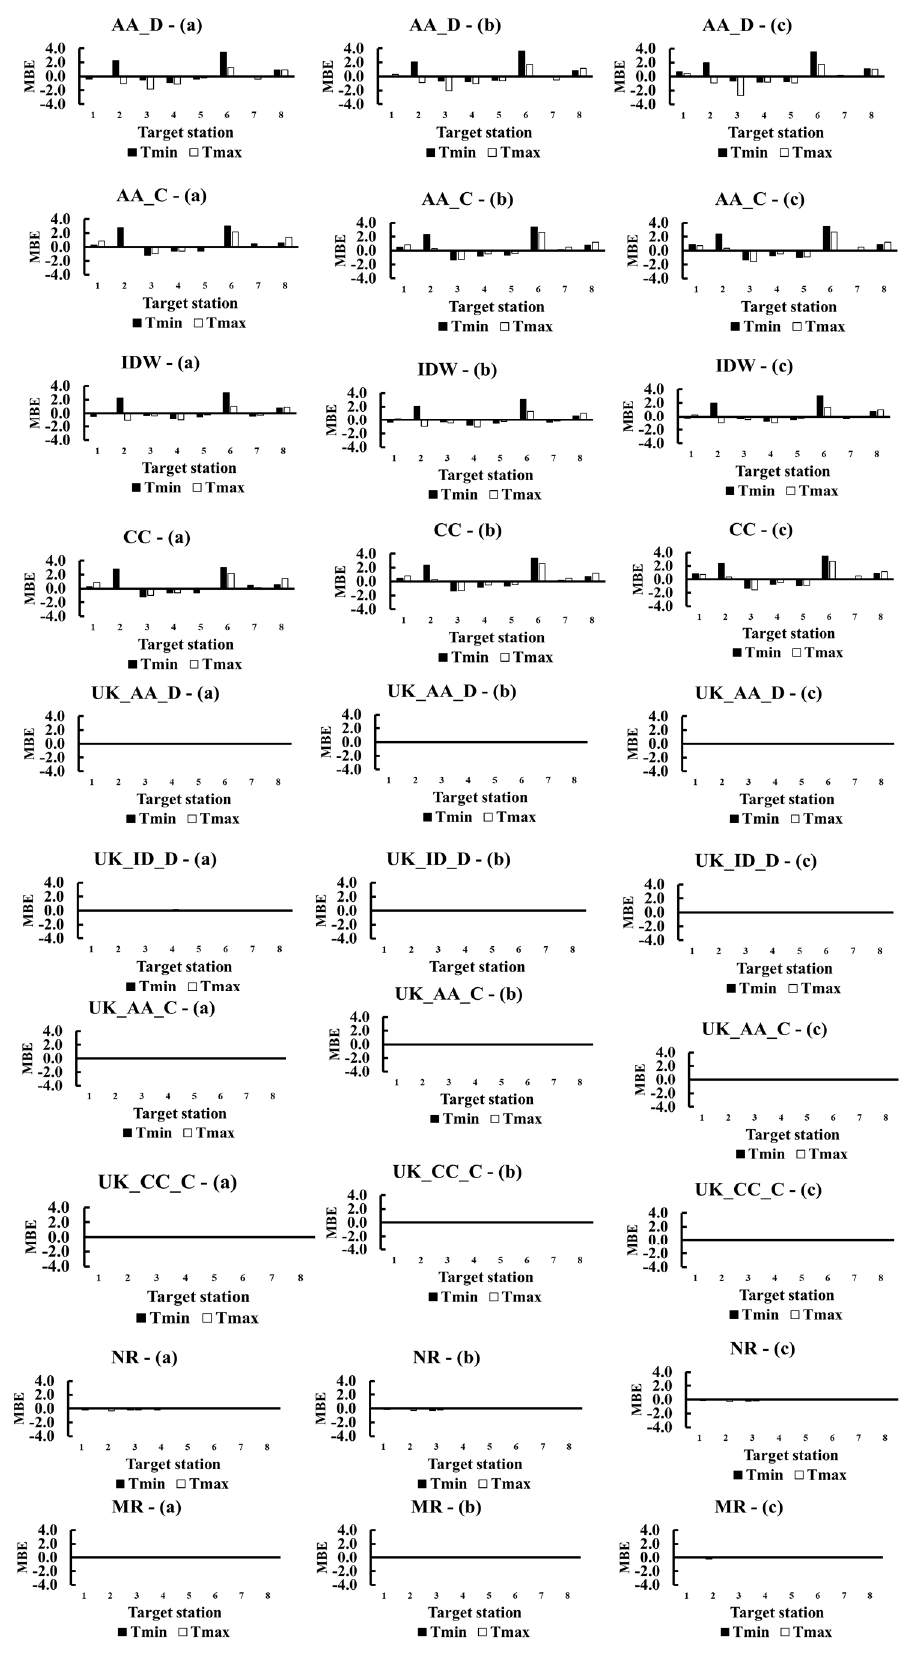
Figure 5. Mean bias error (MBE) for estimating minimum and maximum temperatures for each infilling method at all target stations using ( a ) three target stations, ( b ) 5 target stations and ( c ) 8 target stations.